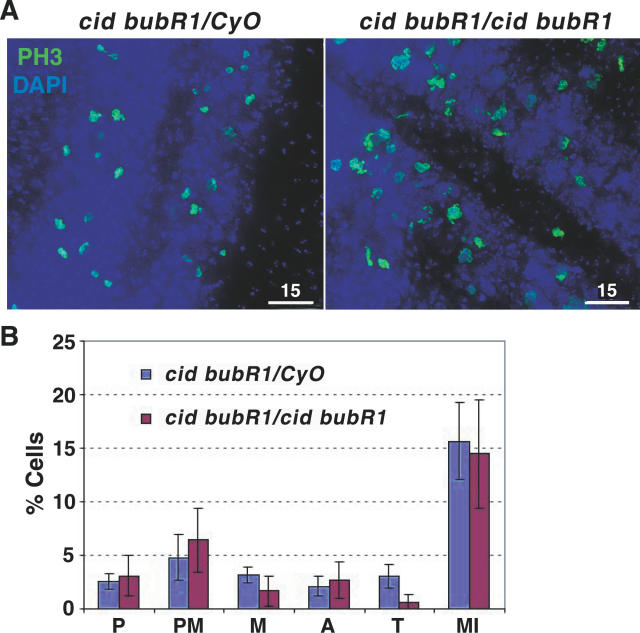
A bubr1 Mutation Partially Suppresses the cid-Mediated Mitotic Delay(A) cid bubr1 double mutants were examined for mitotic progression by staining for PH3 and DAPI. cid bubr1 mutants show an increased nuclear density and number of anaphases compared to cid single mutants. Scale bar indicates 15 μm.(B) bubr1 suppressed the high mitotic index and high number of cells delayed in prophase and prometaphase observed in cid single mutants (compare to ratios in Figure 2B). A, anaphase; M, metaphase; MI, mitotic index; P, prophase; PM, prometaphase; T, telophase.